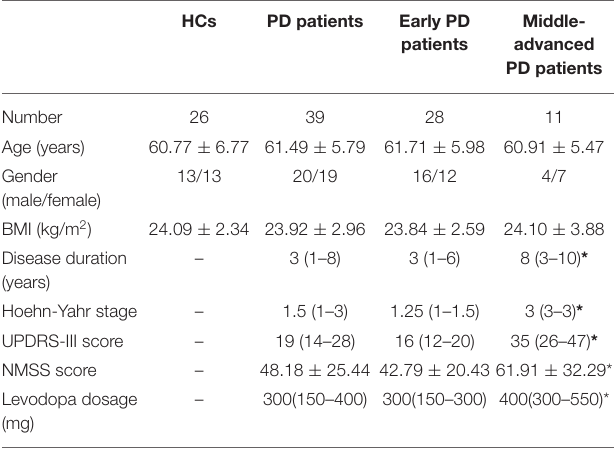
TABLE 1 | Demographic and clinical characteristics of enrolled PD patients and